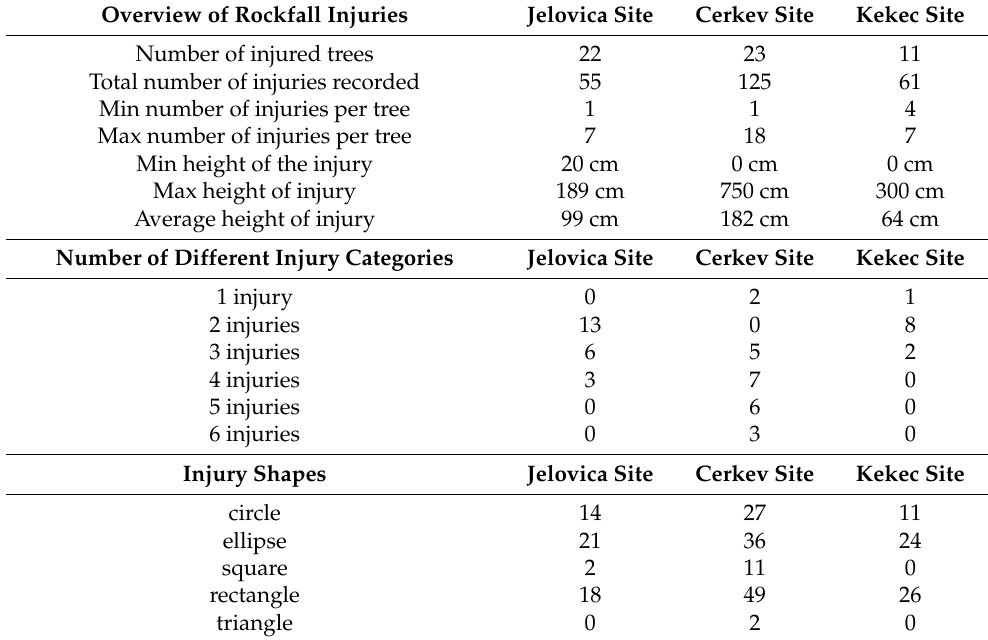
Table 3. An overview of characteristics of rockfall injuries at all three-study